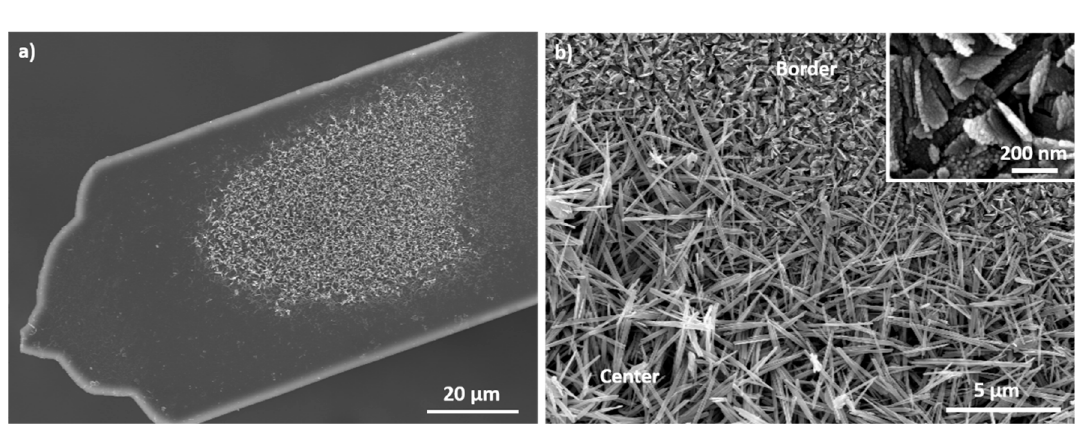
Figure 2. SEM images of CuO nanostructures grown on the surface of AFM cantilever. ( a ) Overview of the sensor. ( b ) Cantilever border (Insert: high magnification on the nanostructures present on the border).